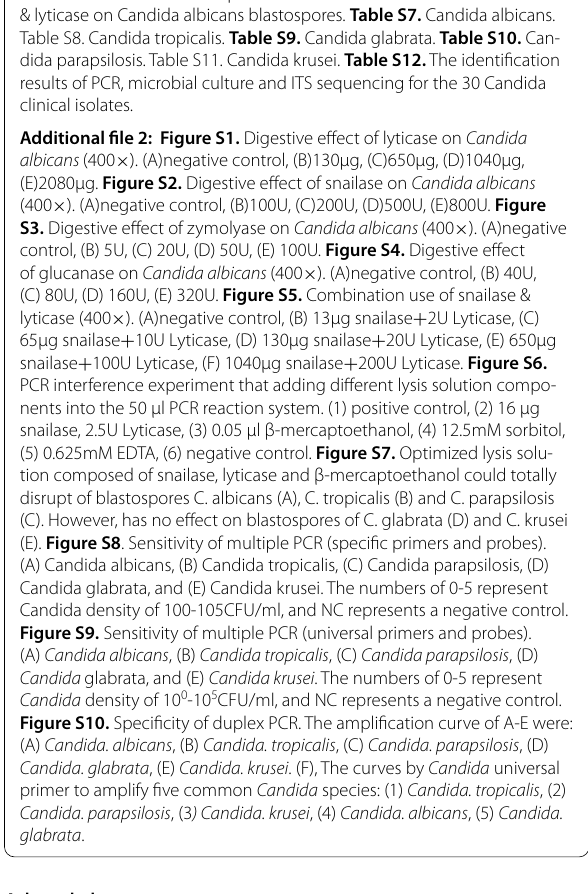
(E). Figure S8 . Sensitivity of multiple PCR (specific primers and probes). (A) Candida albicans, (B) Candida tropicalis, (C) Candida parapsilosis, (D) Candida glabrata, and (E) Candida krusei. The numbers of 0-5 represent Candida density of 100-105CFU/ml, and NC represents a negative control. Figure S9. Sensitivity of multiple PCR (universal primers and probes). (A) Candida albicans , (B) Candida tropicalis , (C) Candida parapsilosis , (D) Candida glabrata, and (E) Candida krusei . The numbers of 0-5 represent Candida density of 10 0 -10 5 CFU/ml, and NC represents a negative control. Figure S10. Specificity of duplex PCR. The amplification curve of A-E were: (A) Candida. albicans , (B) Candida. tropicalis , (C) Candida. parapsilosis , (D) Candida. glabrata , (E) Candida. krusei . (F), The curves by Candida universal primer to amplify five common Candida species: (1) Candida. tropicalis , (2) Candida. parapsilosis , (3 ) Candida. krusei , (4) Candida. albicans , (5) Candida. glabrata